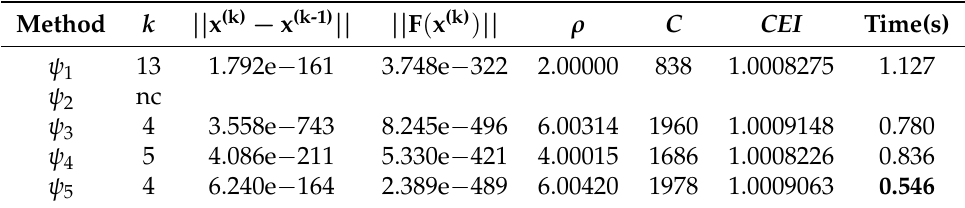
Table 3. Performance of methods for Example